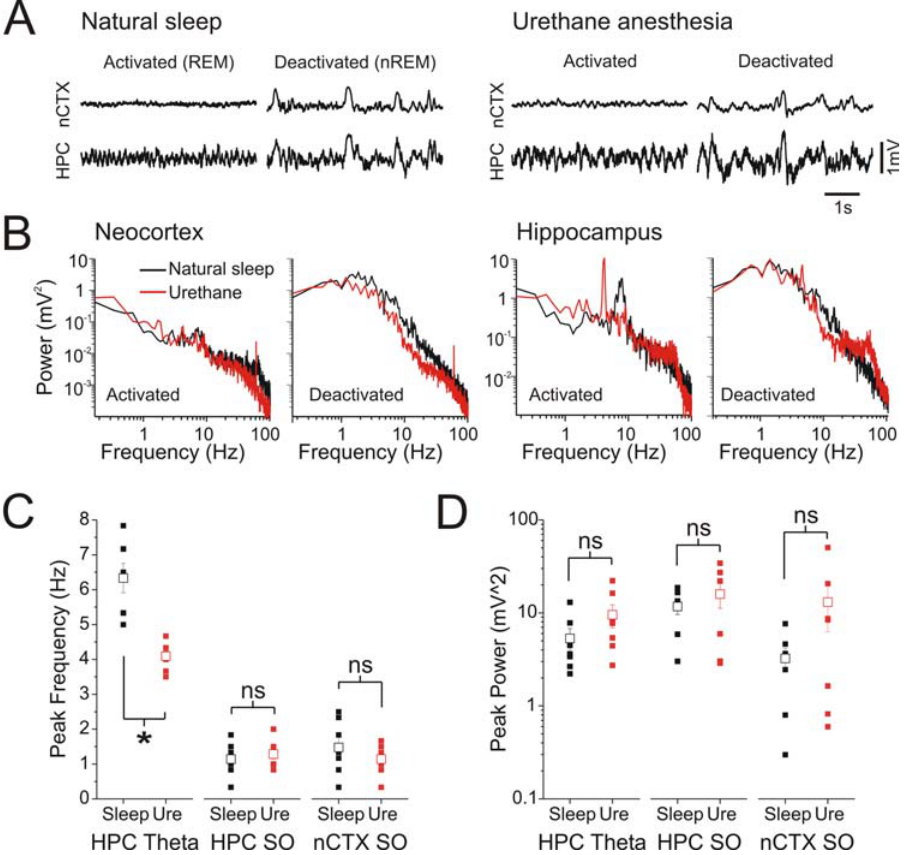
Figure 4. Raw and spectral characteristics of forebrain EEG during activated and deactivated states were similar across during natural sleep and urethane anaesthesia. A) Expanded neocortical and hippocampal EEG traces across natural sleep and urethane anaesthesia in the same animal showing examples of activated and deactivated patterns in both situations. Regardless of condition, activated and deactivated patterns were highly similar. B) Spectra of cortical and hippocampal EEG traces overlaid across conditions for the same electrographic patterns. Although the peak frequency of hippocampal theta power during REM was at a higher frequency ( , 7 Hz) than during the activated state under urethane anaesthesia ( , 4 Hz), all other spectra across conditions appear highly similar. Scatter plot of C) peak frequencies and D) power (right panel) for neocortical and hippocampal signals during the activated and deactivated state for each animal. Except for the peak frequency of hippocampal signals during activated patterns, there were no significant differences across natural sleep and urethane anaesthesia.